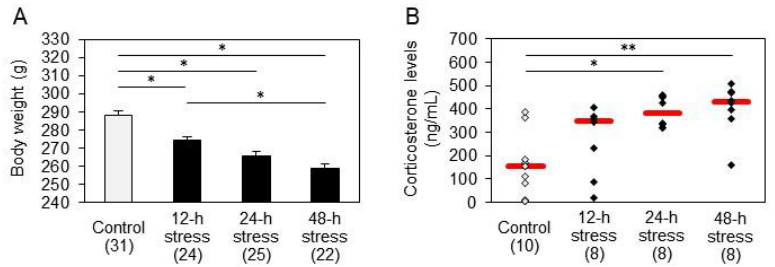
Figure 1. Effects of water immersion stress on rat body weight and serum corticosterone concentrations. ( A ) The rat body weight. Bars in the graph represent the mean ± S.E.M. * p < 0.01 by Tukey–Kramer test. ( B ) Corticosterone levels in the rat serum. Red bars represent the median. Parenthesis: the number of animals. * p < 0.05, ** p < 0.01 by Steel − Dwass test. Stress reduced body weight significantly, which was proportional to the duration of water immersion stress. Serum corticosterone levels were significantly high after 24 h and 48 h stress.